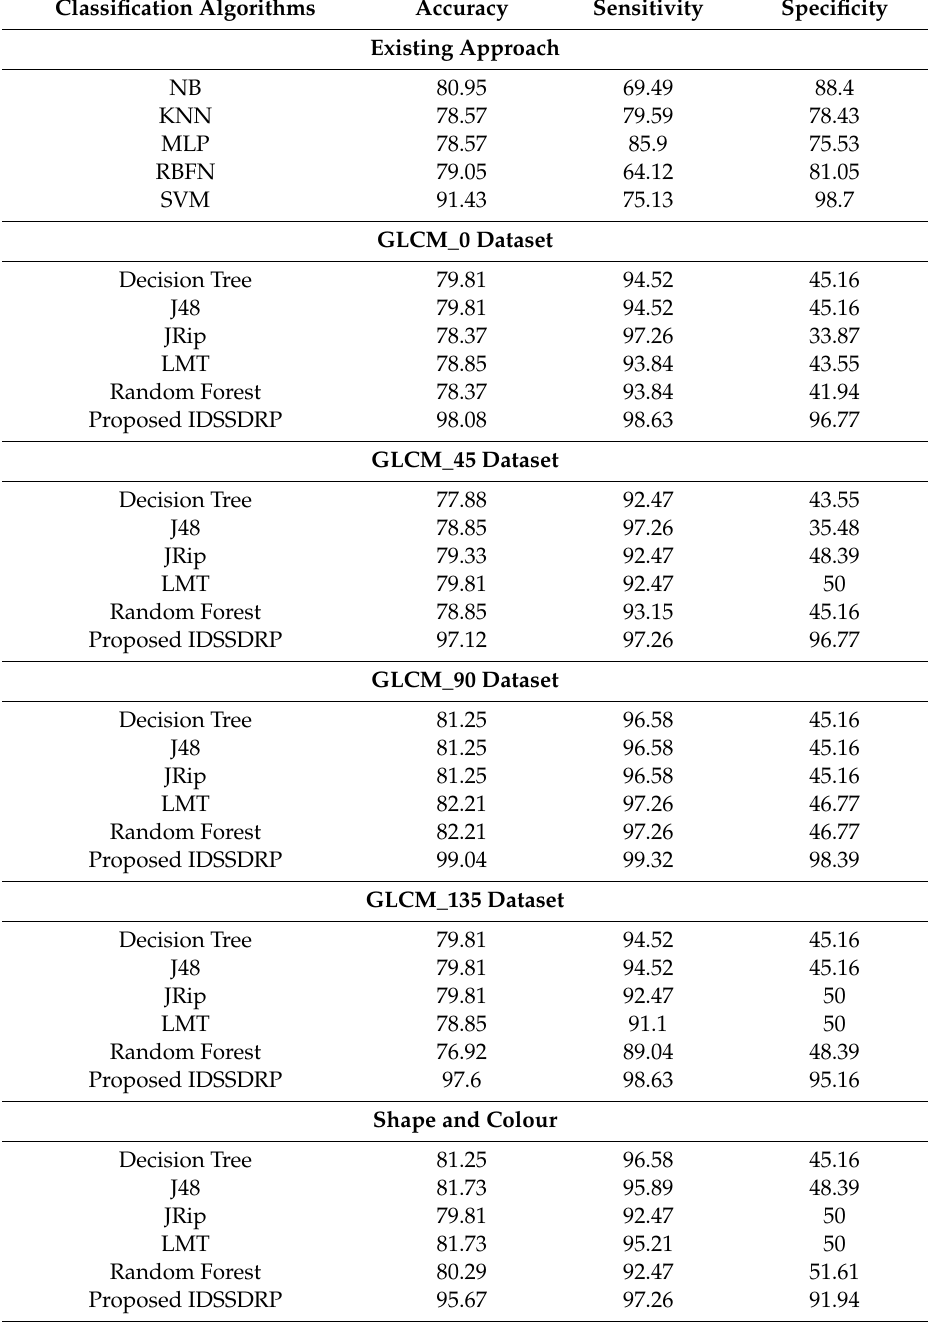
Table 11. Comparison of various classification algorithms